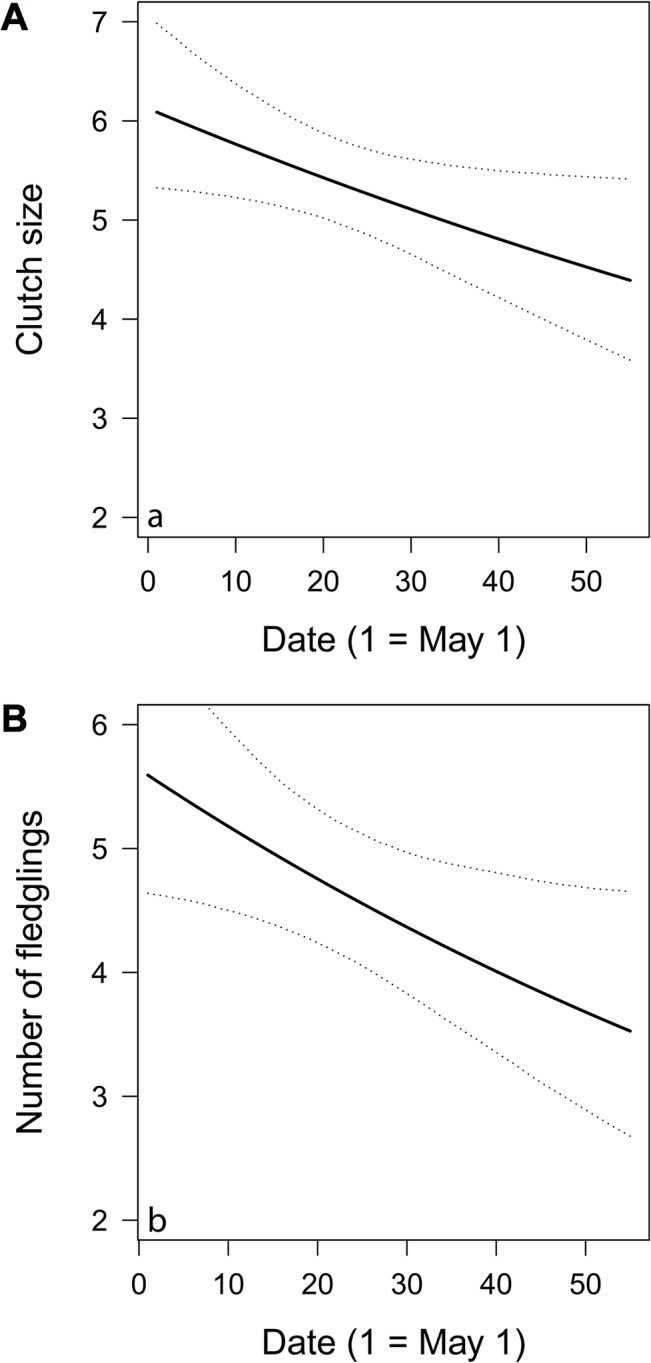
a) Clutch size (n = 115 nests) and b) number of fledglings (n = 64 nests) plotted against start of egg laying.Data were pooled over the three years of study. Plots show fitted values (solid lines) and 95% confidence intervals (dashed lines) based on the highest ranked model including only start of egg-laying in both panels.